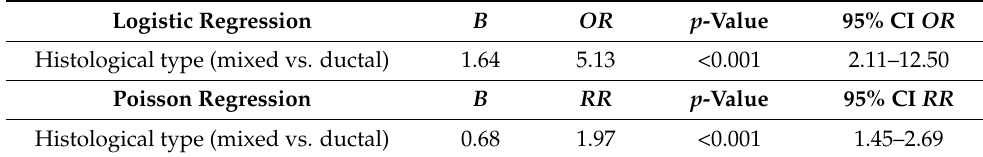
Table 3. Simple logistic and Poisson regression models with five-year mortality as the outcome variable. Logistic Regression B OR p -Value 95% CI OR Histological type (mixed vs. ductal) Poisson Regression RR Histological type (mixed vs.